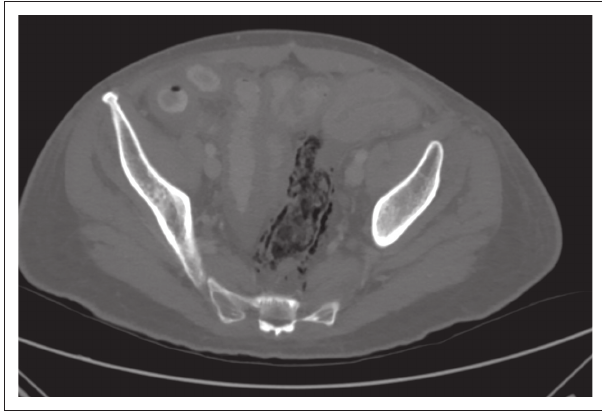
FIGURE 2: Axial post-contrast computed tomography (CT) scan of the pelvis demonstrates pneumatosis coli of the rectum with extra-luminal